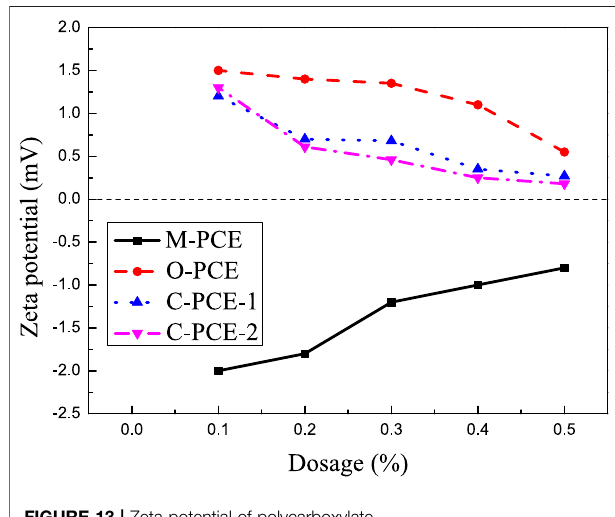
FIGURE 13 | Zeta potential of